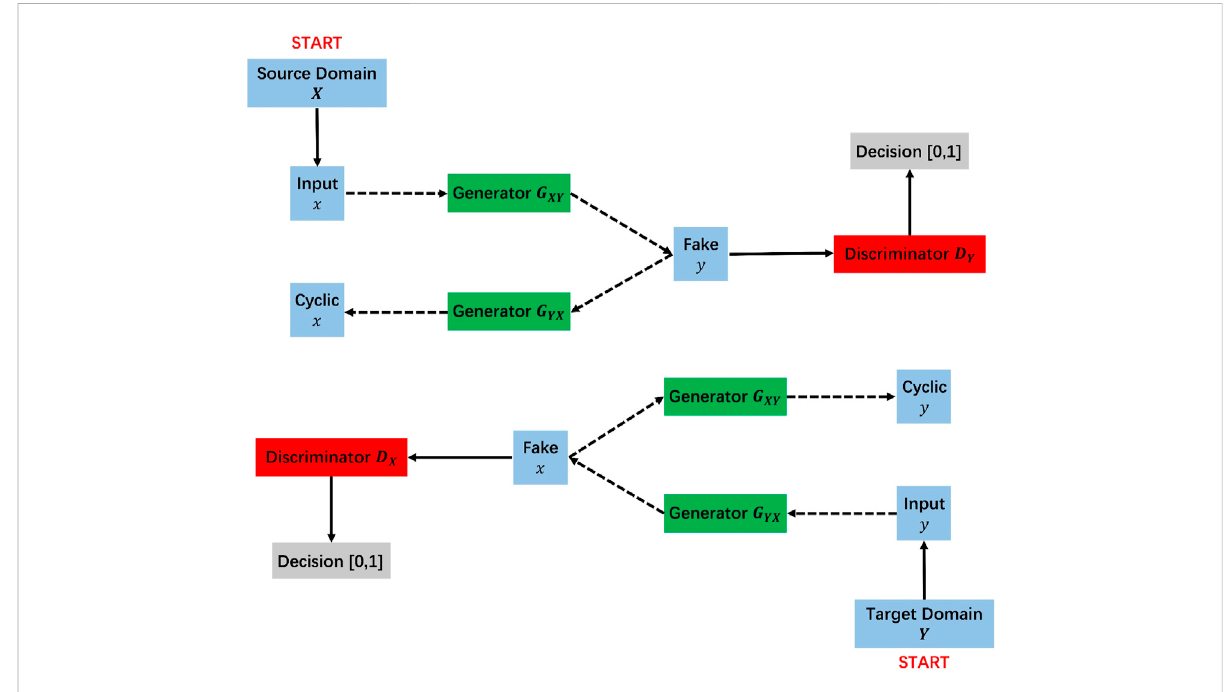
FIGURE 1 The architecture of